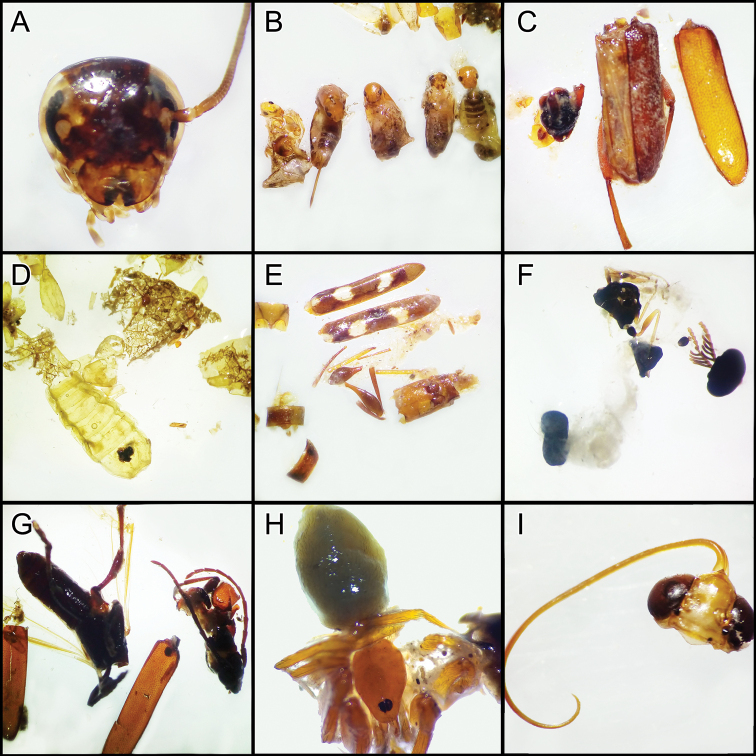
Prey items identified from stomach contents of P.
cleofasensisAPycnoselus
surinamensisB crickets of the family RhaphidophoridaeC beetles of the genus TelabisDCentruroides
elegans
insularisEEuphoria
germinataF and G beetles of the family ElateridaeH spider of the family CaponiidaeI some individuals of lepidopterans.